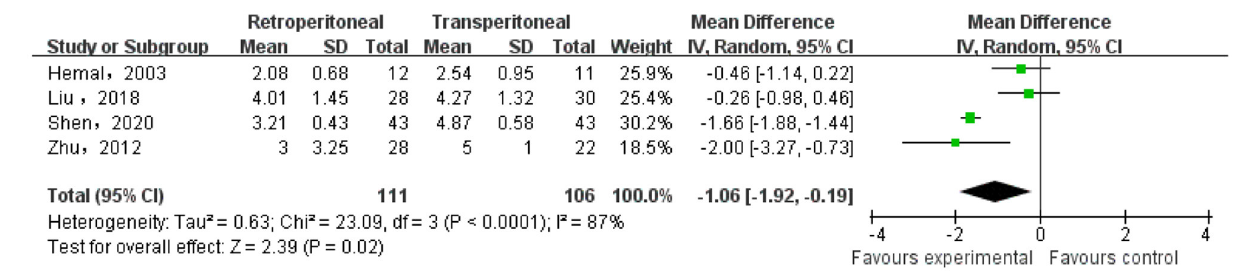
FIGURE 3 | Meta-analysis of the duration of drainage.